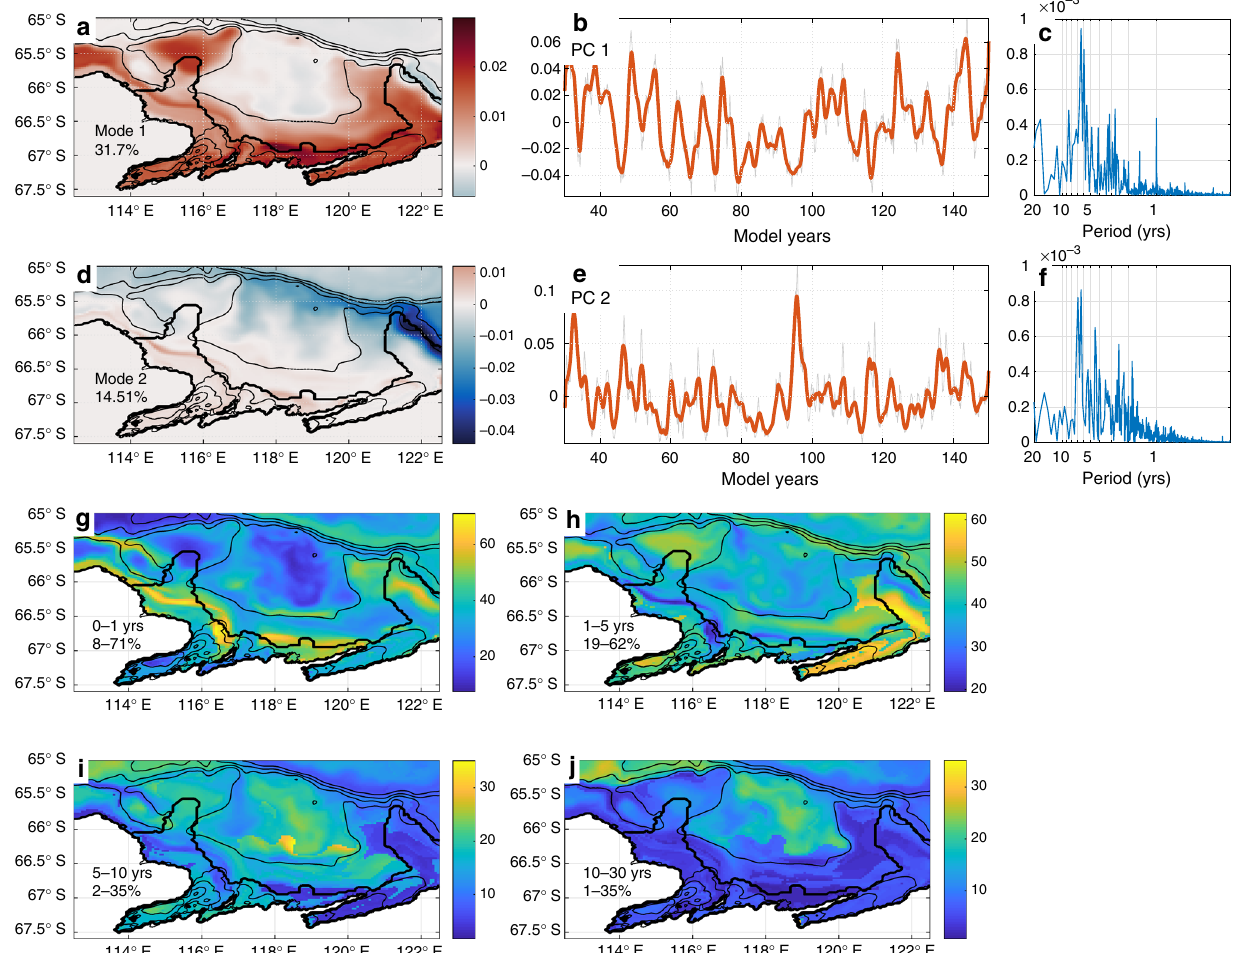
Fig. 4 Intrinsic variability in bottom temperature. a Bottom temperature anomaly EOF mode 1 and b PC 1. c Spectral variance (power spectrum times frequency) for bottom temperature PC 1. d EOF mode 2 and e PC 2. f Spectral variance for bottom temperature PC 2. SSA in-band variance is shown for time bands g 0 – 1 years, h 1 – 5 years, i 5 – 10 years and j 10 – 30 years, with min – max explained variance shown. Thin contours show bathymetry of 500, 1500, 2000, 2500 m. Orange line in b and e is smoothed with a 1.5-yr fi lter, while grey line is raw data. Colour bars in g – j are scaled to the min/max variance range, as given as percentages in the lower left hand corner of each